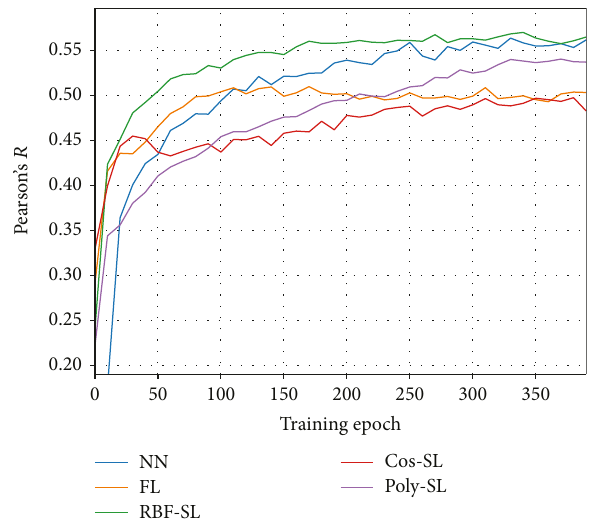
Figure 1: Emotify dataset, average prediction quality over all 9 GEMS